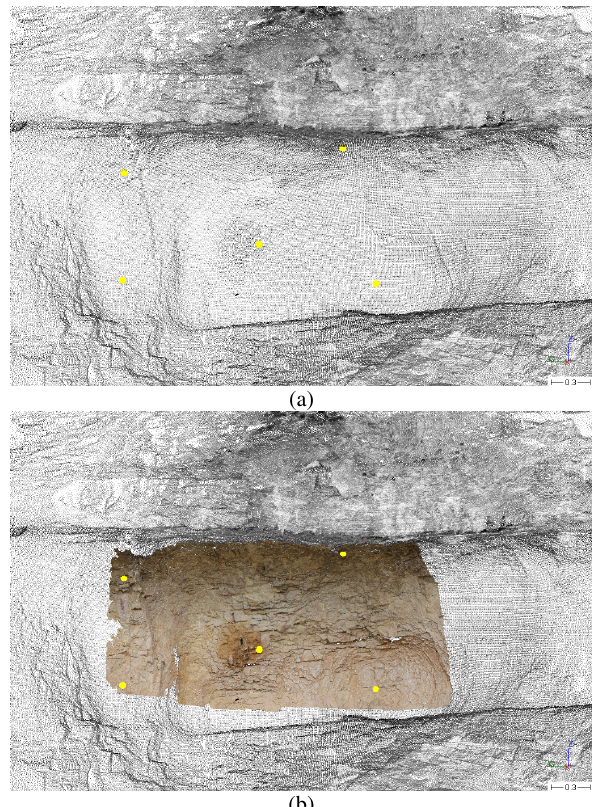
Figure 5. Set of homologous points (in yellow) measured to merge both datasets: a) laser scanning point cloud data (in greyscale); b) integrated dense colourful photogrammetric point cloud.